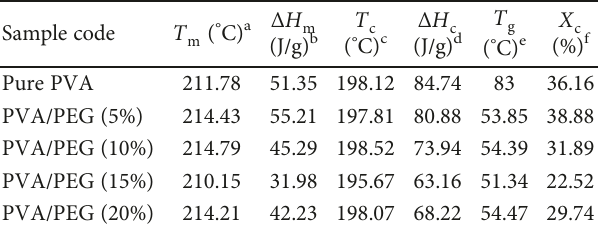
Table 2: DSC data for PVA and PVA/PEG blends. Sample